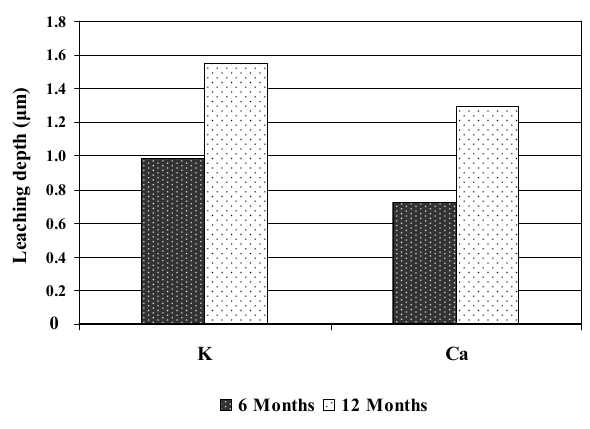
Fig. 9. Leaching depth of the specimens exposed on the main rack.